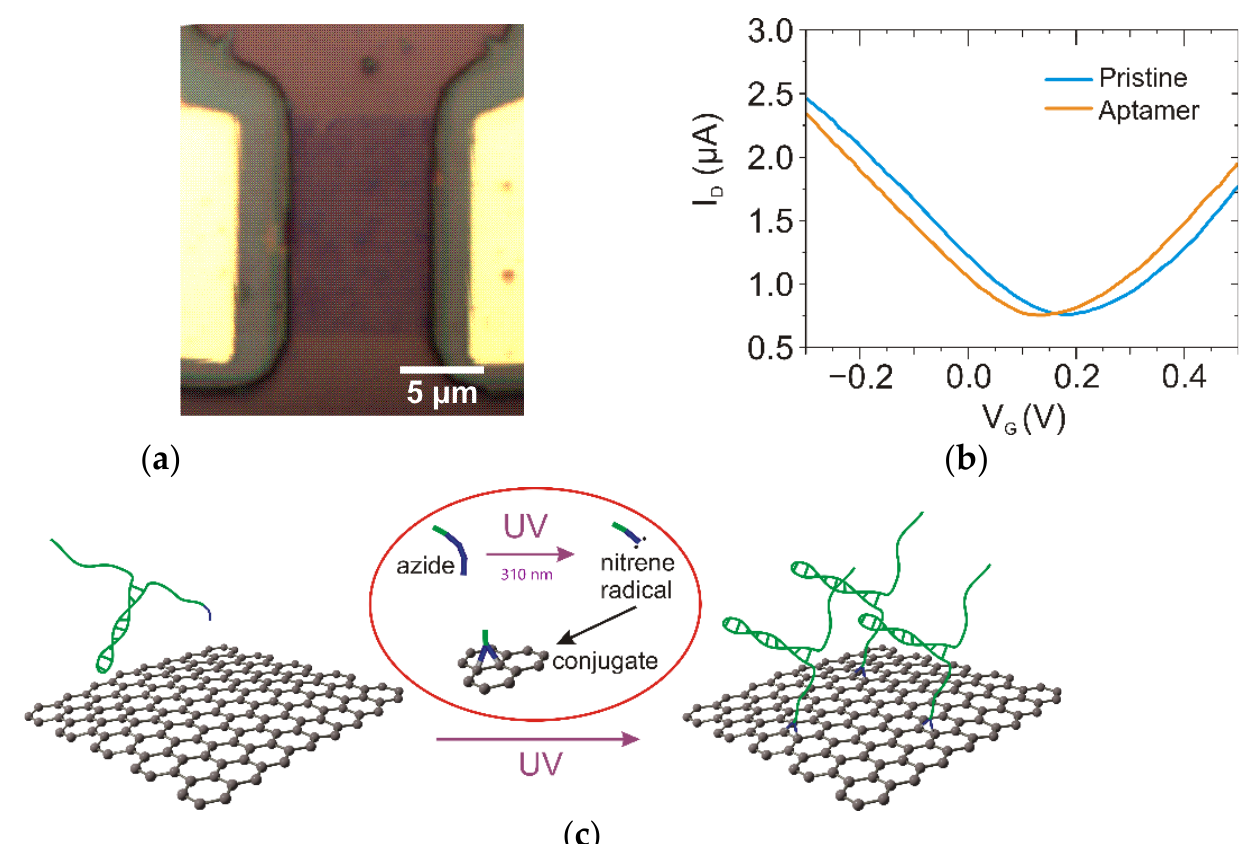
Figure 1. Photochemical immobilization of aptamer on graphene channel of FET. Optical image of GFET channel with passivated gold electrodes ( a ). Change in I-V G curves for GFETs modified with azide-aptamer (V DS = 100 mV) ( b ). ( c ) Scheme of photochemical binding azido-modified aptamer to graphene: azide group under 310 nm UV light converts to nitrene radical, which covalently binds to graphene by pericyclic [2 + 1] cycloaddition.